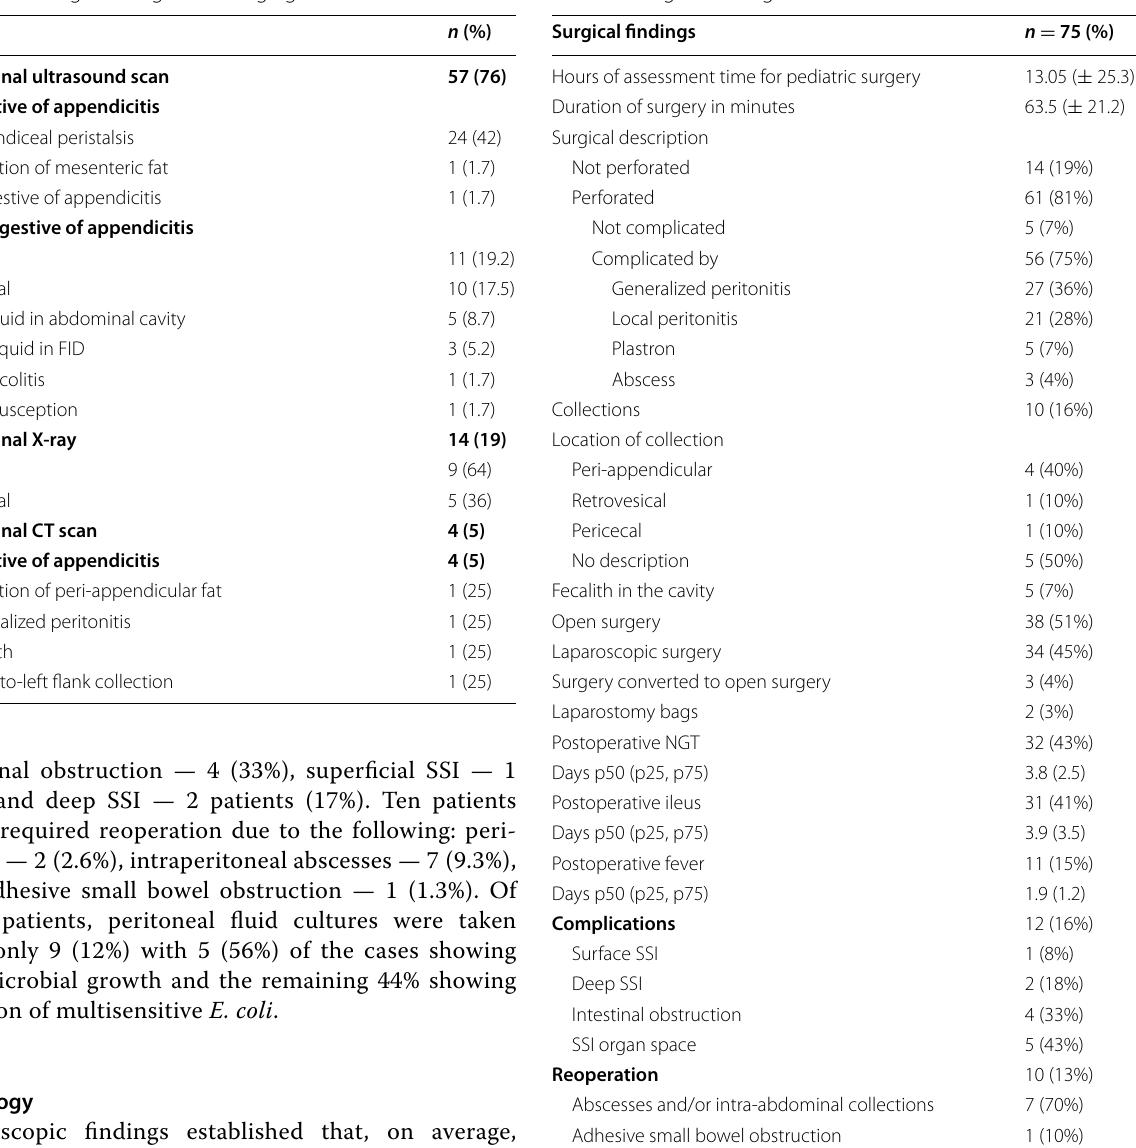
Table 2 Findings on diagnostic imaging Table 3 Surgical